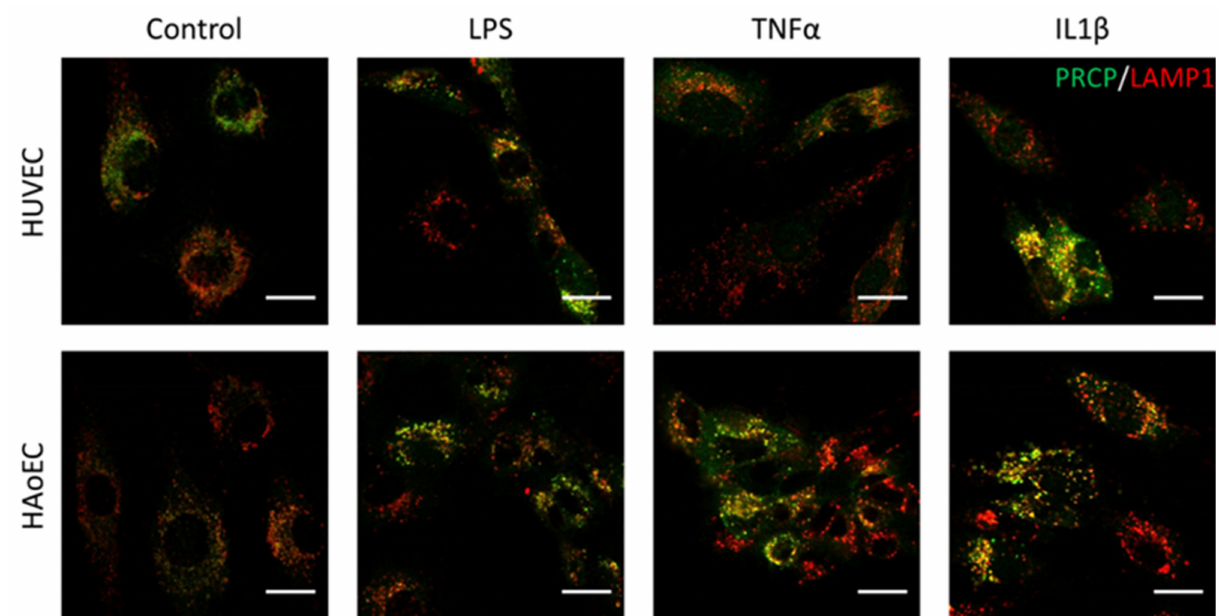
Figure 6. PRCP is observed in lysosomes of HUVEC and HAoEC. Double staining of PRCP and LAMP1 in control, LPS-, TNF α -, and IL-1 β -stimulated HUVEC. Cells were incubated for 16 h with the different stimuli, fixed with 4% PFA, permeabilized with 0.1% Triton X-100 and stained for PRCP (green) and LAMP1 (red). Overlap of LAMP1 and PRCP was observed as yellow color. Representative images of three independent experiments. (bar = 20 µ m).